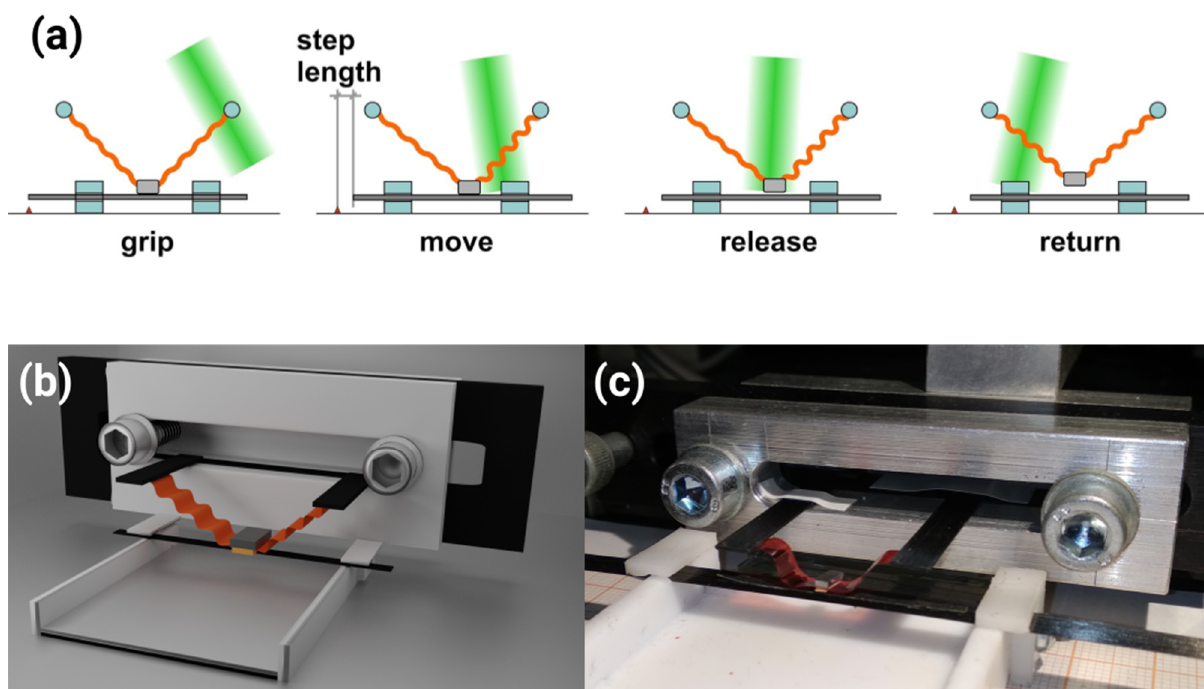
Figure 2. ( a ) The light-driven linear inchworm motor principle of operation. During the slow scan of the laser beam (green), the deformation traveling along two light-responsive elastomer accordion-like actuators (orange) results in the gripper (gray) coupling to the shaft by friction, pulling the shaft by one step, releasing the gripper by pulling it up and returning it to the initial position with the relaxation of the elastomer. Three-dimensional model of the linear motor ( b ) and a photograph of the device ( c ) (the M6 screw heads, 10 mm in diameter, give a scale reference).